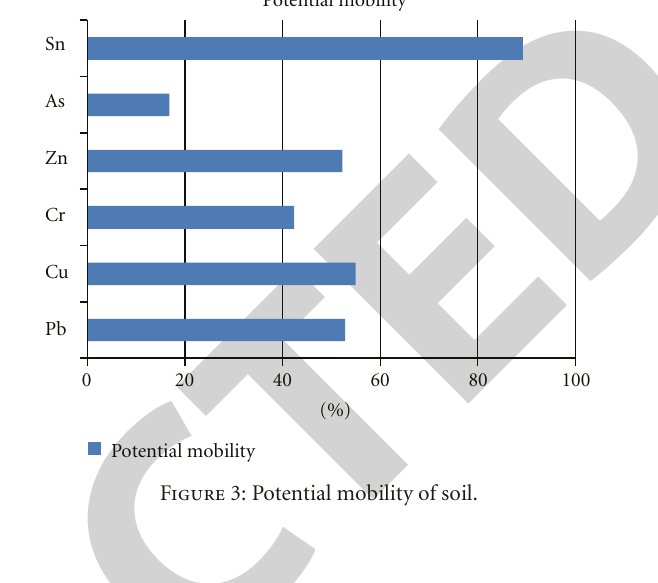
Figure 2: Percentages of metals in di ff erent fractions.